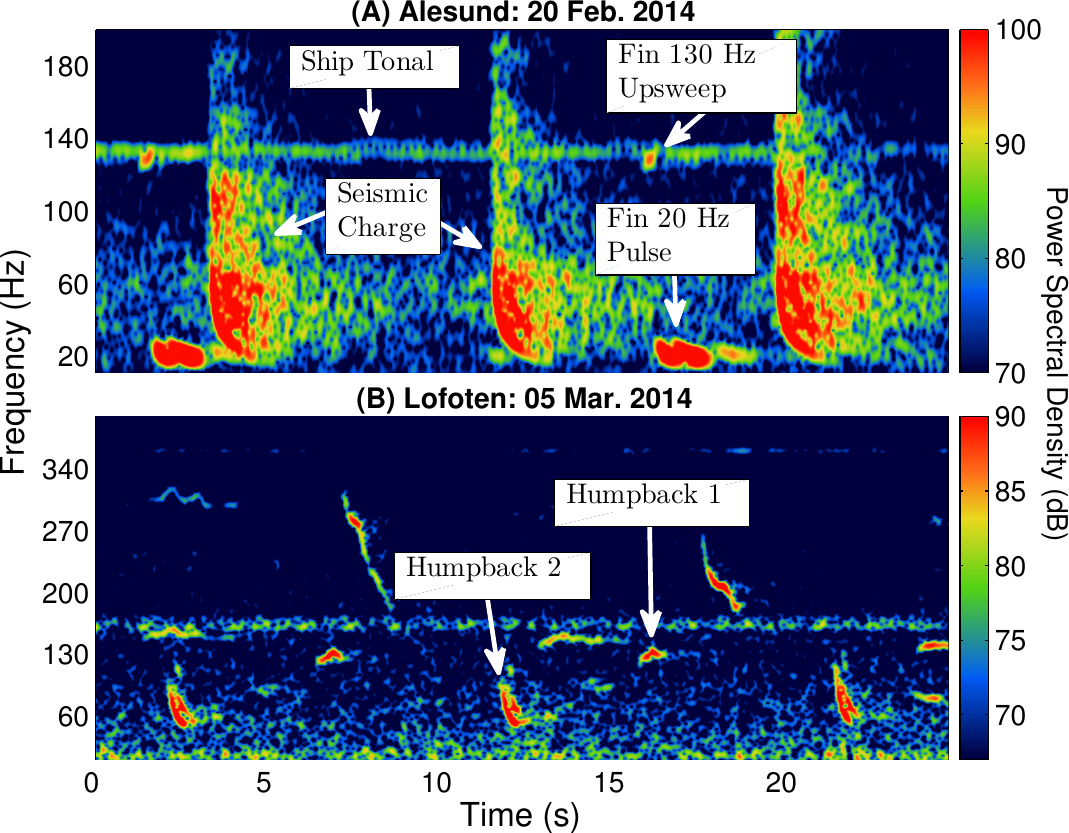
Figure 2. Plot ( A ) displays a spectrogram containing three seismic airgun signals, a ship tonal, two fin whale 20 Hz pulse (doublets), and two fin whale 130 Hz upsweeps observed off the coast of Alesund, Norway on 20 February 2014. As displayed in plot ( A ), the seismic airgun signal overlaps within the same frequency range as the 20 Hz pulse and 130 Hz upsweep, while the ship tonal overlaps within the same frequency range as the 130 Hz upsweep. Plot ( B ) displays several humpback whale vocalizations observed off the coast of Lofoten, Norway on 5 March 2014. As displayed in plot ( B ), the two specified humpback vocalizations overlap within the same frequency range as the 130 Hz upsweep and 30–100 Hz downsweep (See Figure